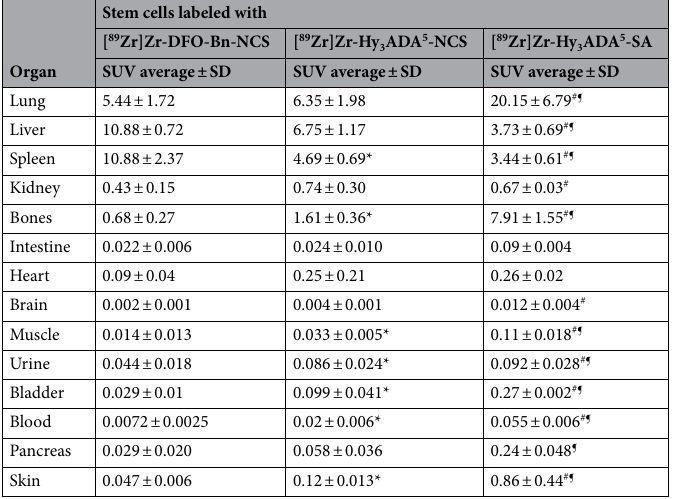
Table 3. Uptake (SUV) and biodistribution of stem cells labeled with [ 89 Zr]Zr-DFO-NCS (n = 4) , [ 89 Zr]